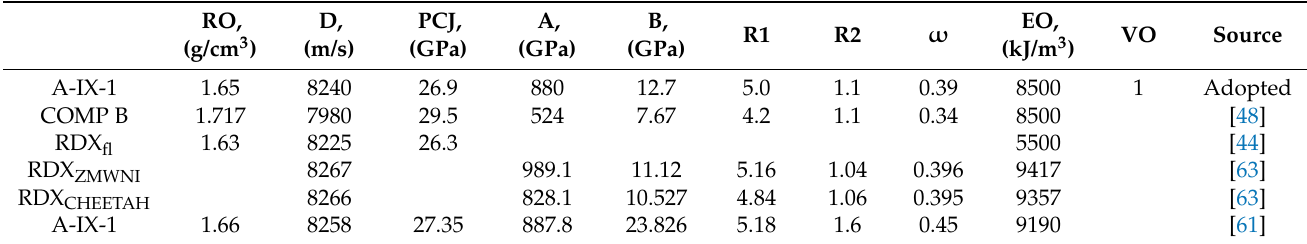
Table 11. Material parameters of the metallic components of the PG-7VM warhead used in simulations. RO,